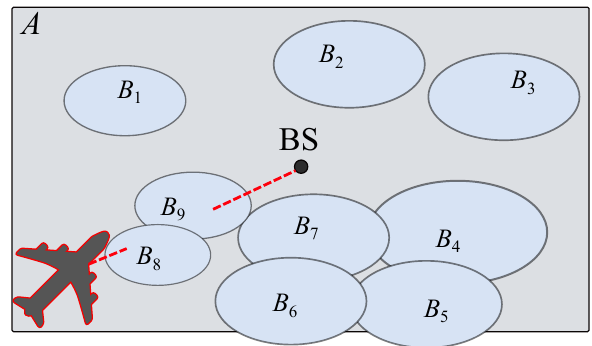
Figure 4. Illustration of cloud blockage at a certain cloud